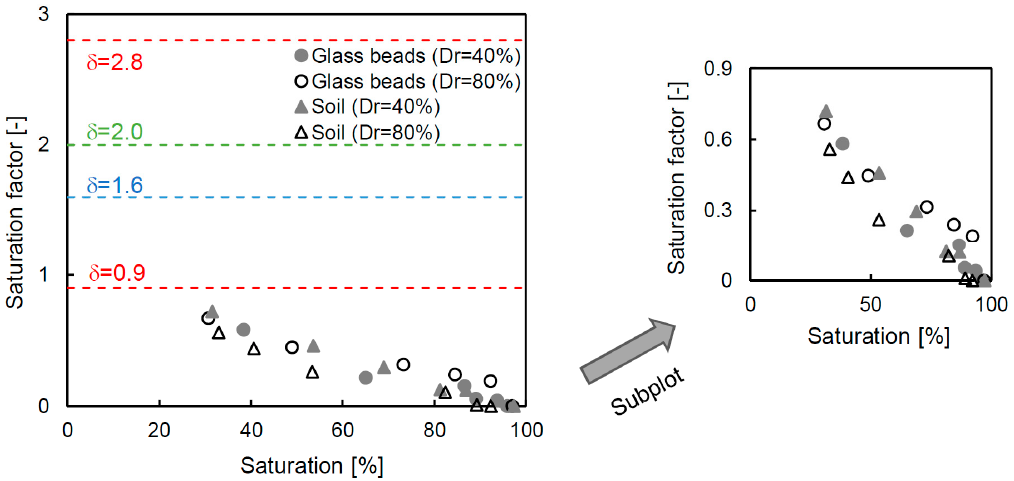
Figure 9. Saturation factors at every saturation step.